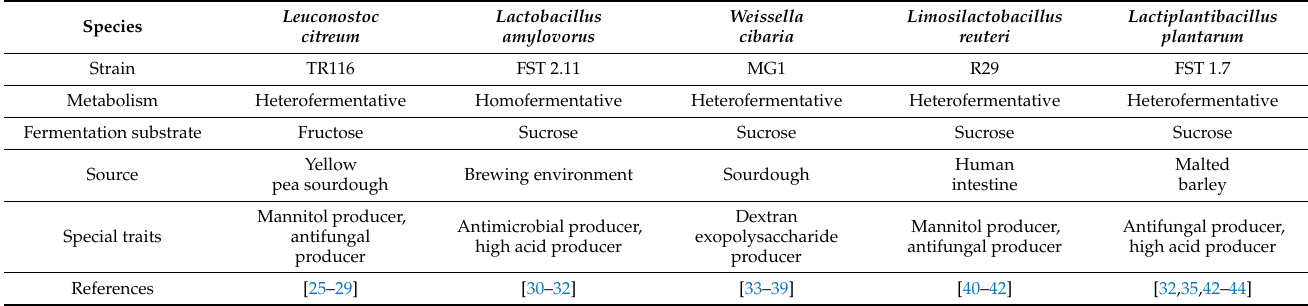
Table 1. Attributes of the lactic acid bacteria used for experimental